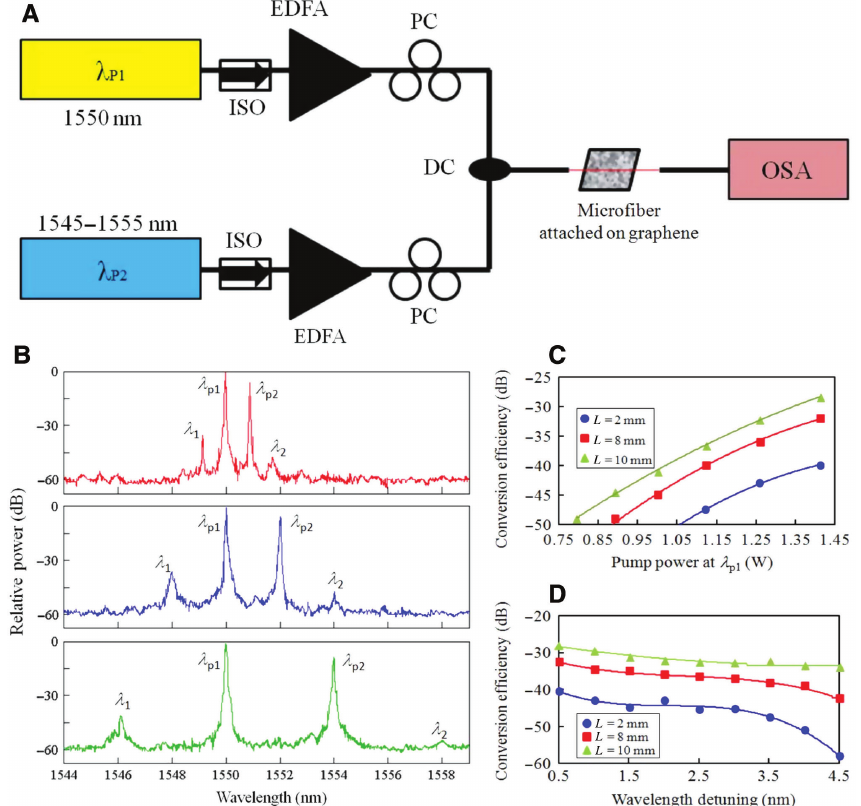
Figure 20: FWM wavelength conversion using microfiber-attached graphene. (A) Experimental setup for the observation of FWM, where two pump beams derived from a fixed-wavelength laser ( λ tunable laser ( λ ), respectively, are launched into a microfiber attached graphene. (B) Output spectra from the microfiber-attached p2 graphene with a contact length of 8 mm, measured at three wavelength detuning values (from top to bottom): 1, 2, and 4 nm with the two pump powers fixed at 1.25 W and 200 mW, respectively. (C) Dependence of the conversion efficiency at λ different contact lengths L with the wavelength detuning fixed at 2 nm and the power of λ the conversion efficiency at λ on the wavelength detuning for different contact lengths L with the two pump powers fixed at 1.25 W ( λ 1 200 mW ( λ ), respectively. Reproduced with permission [283]. Copyright 2014, IEEE Photonics p2